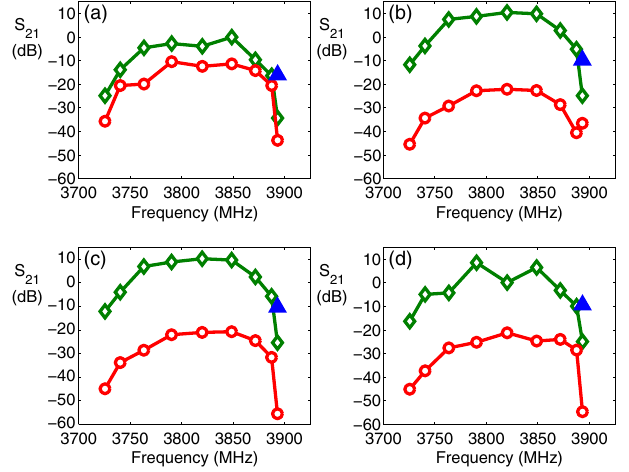
FIG. 3. Evolution of the relative HOM transmission spectra of the fundamental passband modes, from cavity reception (inset a), FPC installation (inset b, showing the detuning of the HOM1 notch filter), HOM retuning (inset c) and after installation of all ancillaries (inset d). In each plot, diamonds show the FPC-HOM2 passband, circles the PU-HOM1 passband and the triangle indicates the fundamental mode FPC-PU